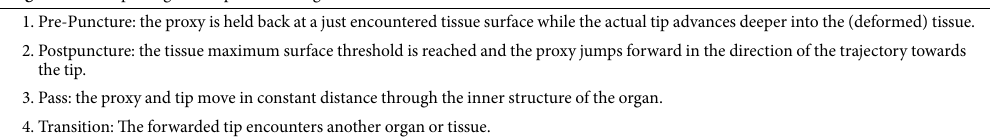
Algorithm 2 Haptic algorithm phases during needle insertion.